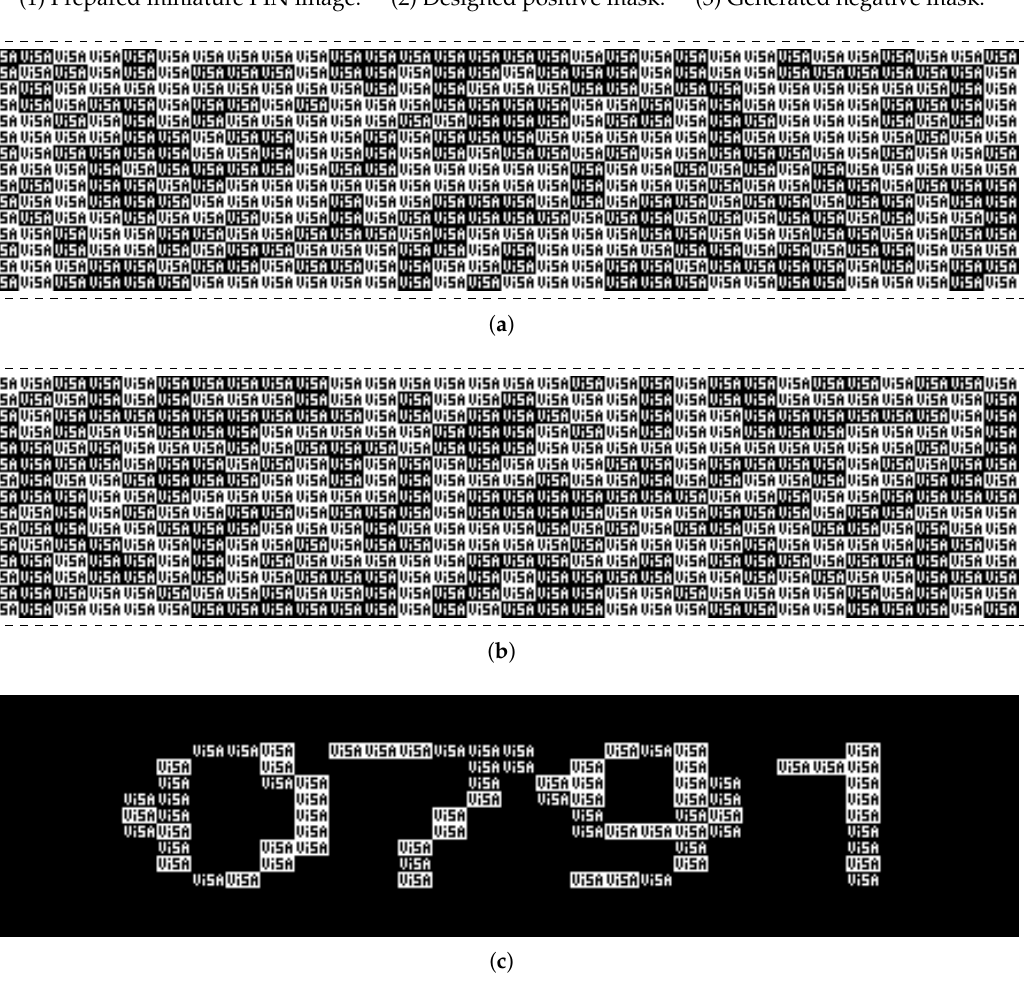
Figure 10. Results obtained by personalization of shares with the proposed pictogram-based VC technique. Logo-based positive and negative binary masks have been designed for business promotion from a PIN image. The appearance of the generated shares is made aesthetic and used as a new medium of communication. ( a ) Generated Advertising Share 1 (encrypted image); ( b ) Generated Advertising Share 2 (encrypted image); ( c ) decoded PIN number by share